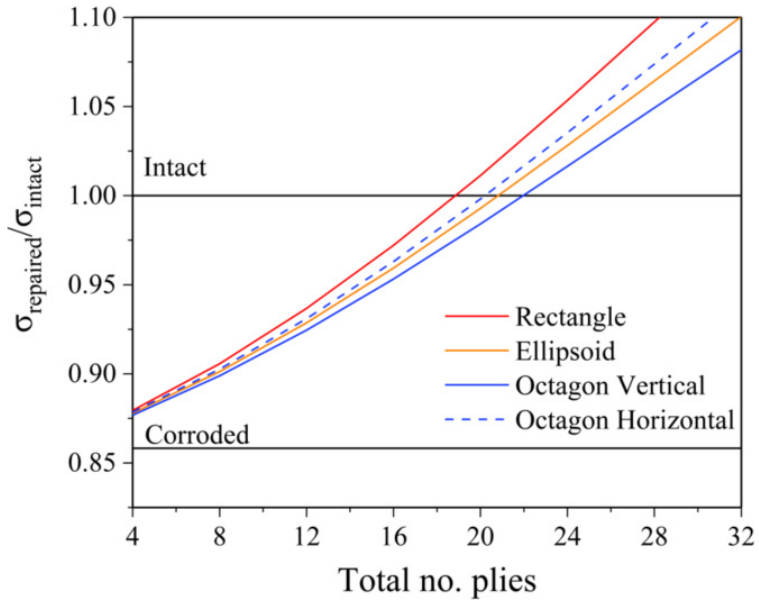
Figure 15. OFAT analysis for determining the repair’s optimal shape (compression model).